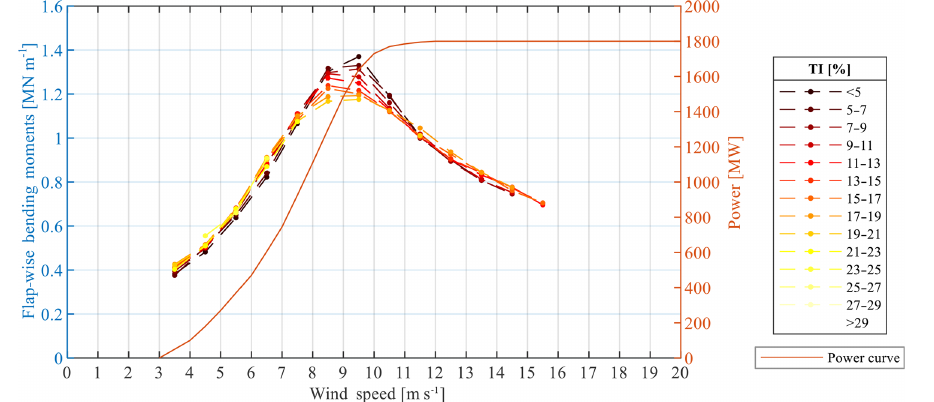
Figure 19. Wind turbine power curve and bending moments recorded at blade root B according to flap-wise direction as a function of wind speed and considering different turbulence intensities (5 February to 17 December 2019: 20027 10min time